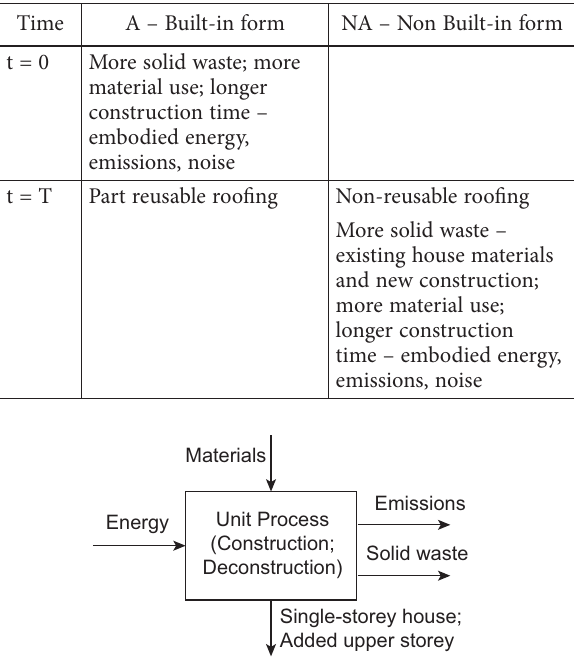
Table 2. Comparison of environmental issues